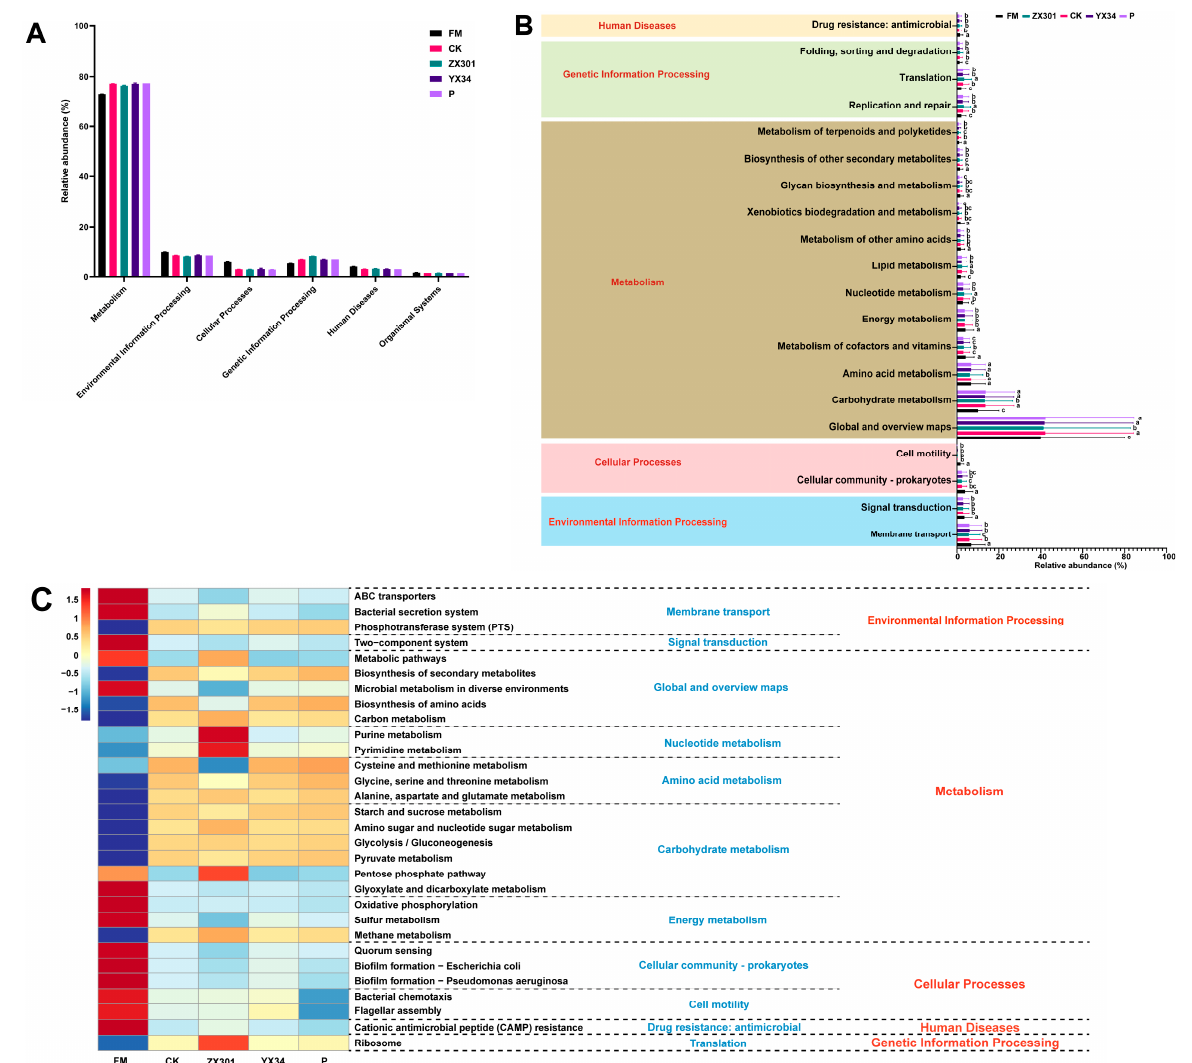
Figure 5. Dynamics of bacterial functional profiles analyzed by PICRUSt2 ( n = 3): ( A ) Level 1 metabolic pathways. ( B ) Level 2 Kyoto Encyclopedia of Genes and Genomes (KEGG) ortholog functional predictions of the relative abundances of the top 20 metabolic functions. ( C ) Level 3 KEGG ortholog functional predictions of the relative abundances of the top 30 metabolic functions. FM, fresh matter; CK, control group; ZX301, pediococcus pentosaceus -treated group; YX34, lactobacillus planturum -treated group; P, a commercial inoculant-treated group containing lactobacillus plantarum .